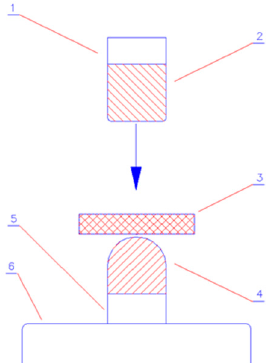
Figure 1. Design of a device for testing the shock-absorbing properties of the impact samples: 1—handle for fixing the hammer, 2—hammer releasing device, 3—sample, 4—anvil, 5—force sensor, and 6—stand base.